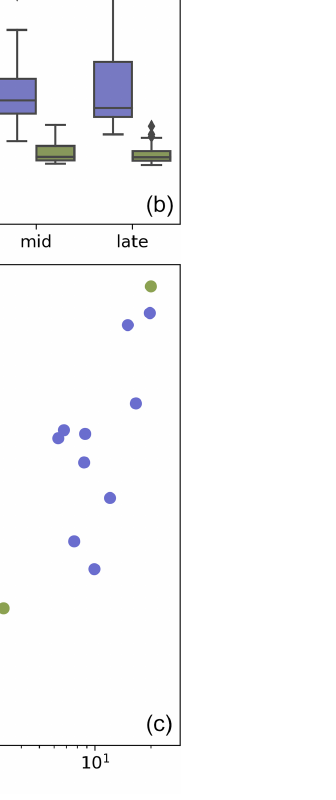
Figure 4. k -means clustering of RCP 4.5 glacial-buffering metrics (a, b) and scatter plot of basin aridity index and percentage glacier coverage colored by cluster (c) . In the box plots of glacial-buffering metrics over time, colored boxes indicate the interquartile range among single-basin results in each cluster, with lines indicating the median, whiskers indicating the range of the full distribution, excluding the outliers identified by the diamonds. In the scatter plot, each dot indicates the ensemble mean of each quantity for a single basin. Recall that the aridity index is a ratio P/ PET (Sect. 2.4), such that higher values indicate wetter